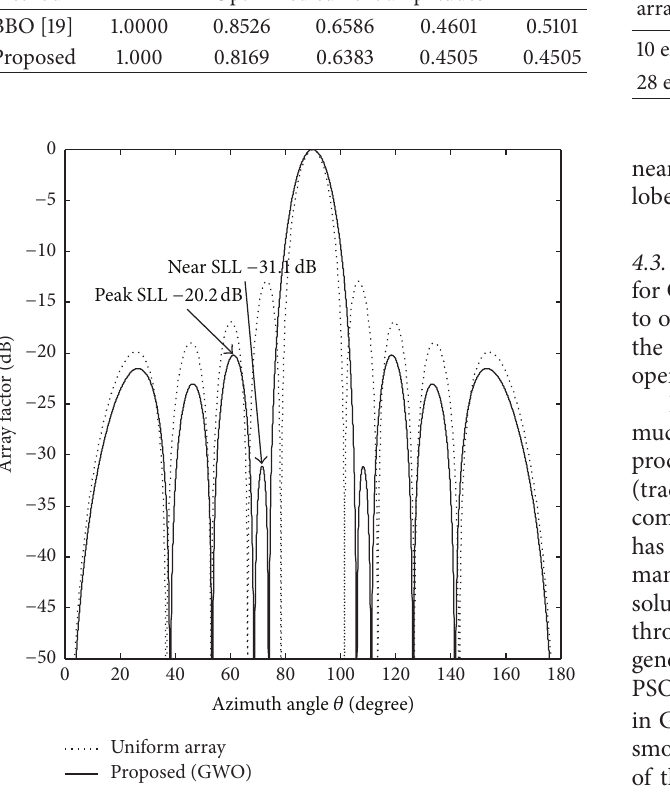
Figure 11: Array pattern for Example 8.